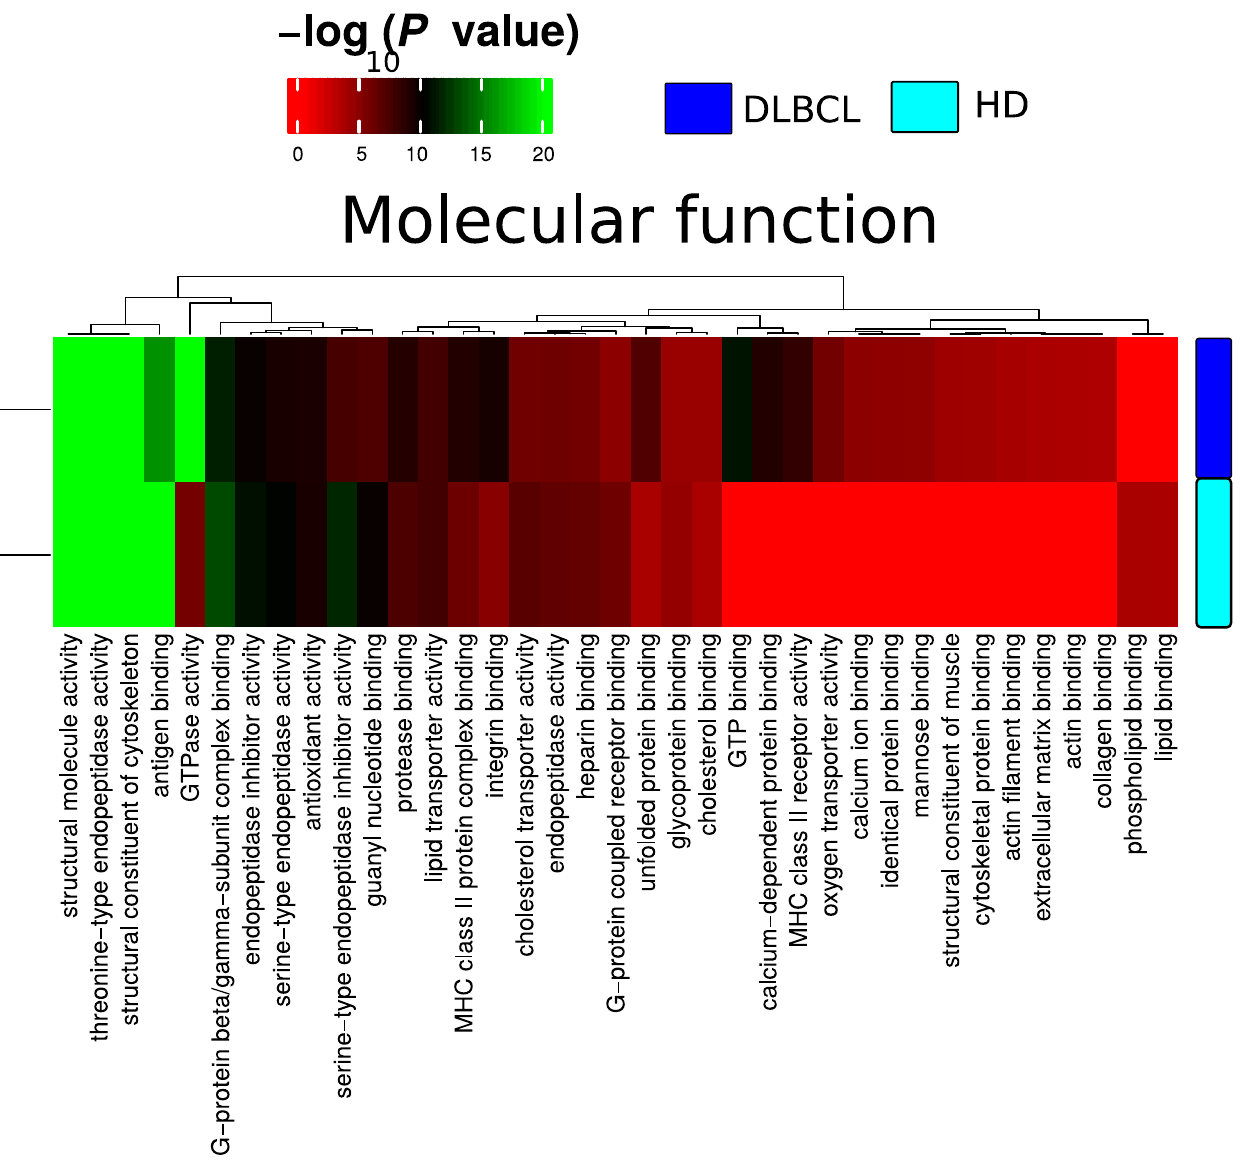
Figure A2. Summary of functional categories that are either enriched in HD or DLBCL based on functional enrichment in all identified protein from DLBCL and HD when compared with molecular function.